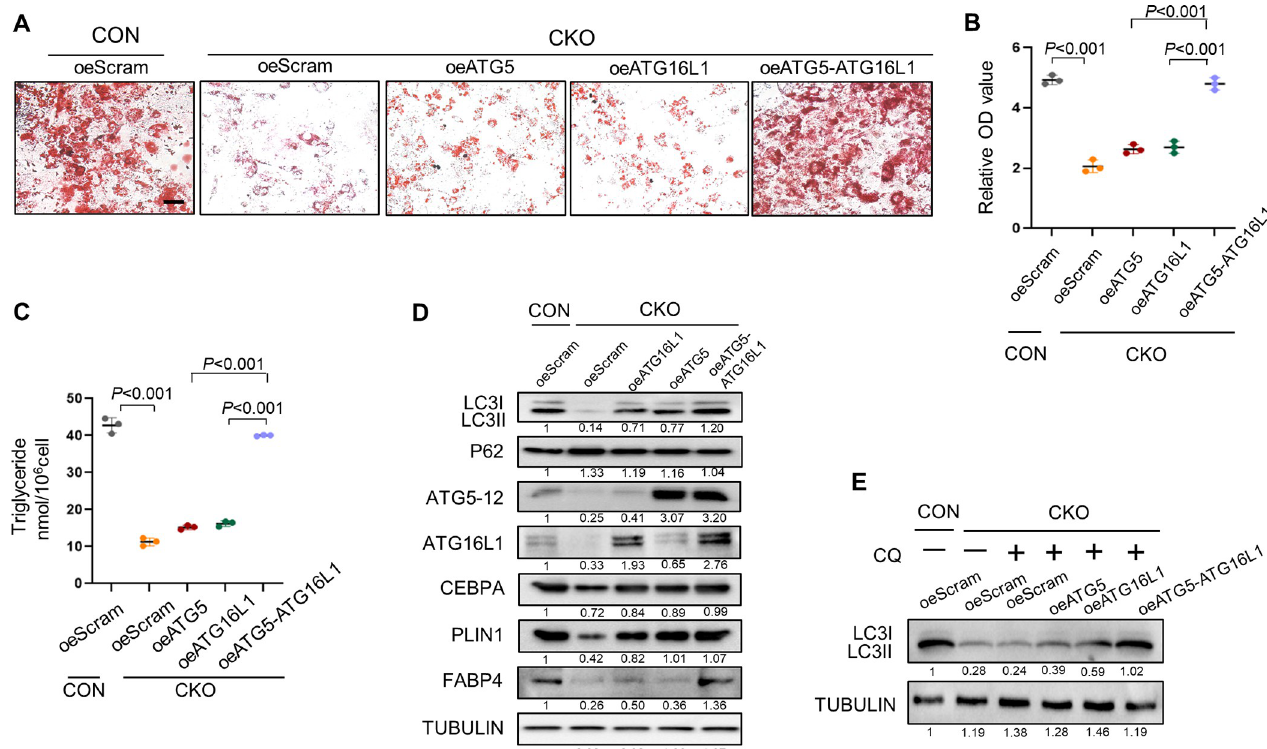
Fig 6. Overexpression of ATG5 and ATG16L1 rescues adipogenic potential of Aff4 -deficient cells. (A, B) Representative images and quantification of oil red O staining of CON and CKO preadipocytes overexpressing ATG5 or ATG16L1. Scale bar, 25 μ m. n = 3. (C) Triglyceride quantification. n = 3. (D) Western blot analysis of autophagy related markers and adipogenic markers. (E) Western blot analysis of LC3. CQ, chloroquine.